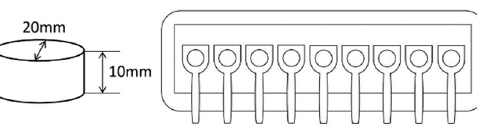
Figure 1. Schematic illustrations of the stimuli (left) and experimental setups (right): The bite-sized gel-type food stimuli were placed on disposable plastic spoons in a row.